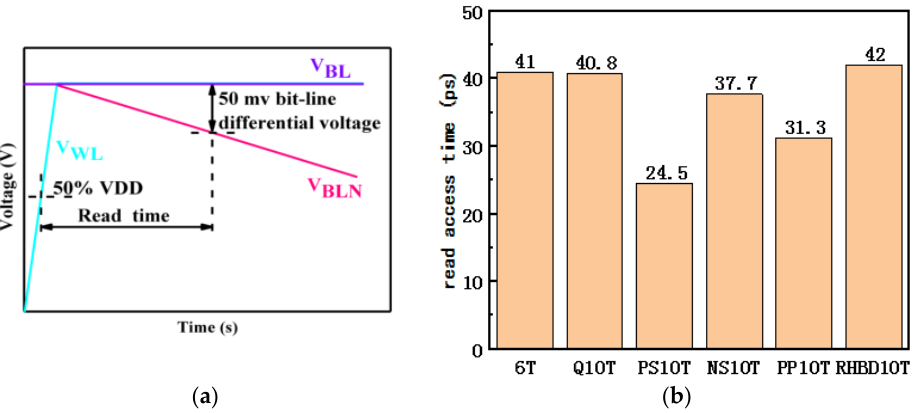
Figure 5. Read access time. ( a ) Measuring method. ( b ) Read access time comparison.